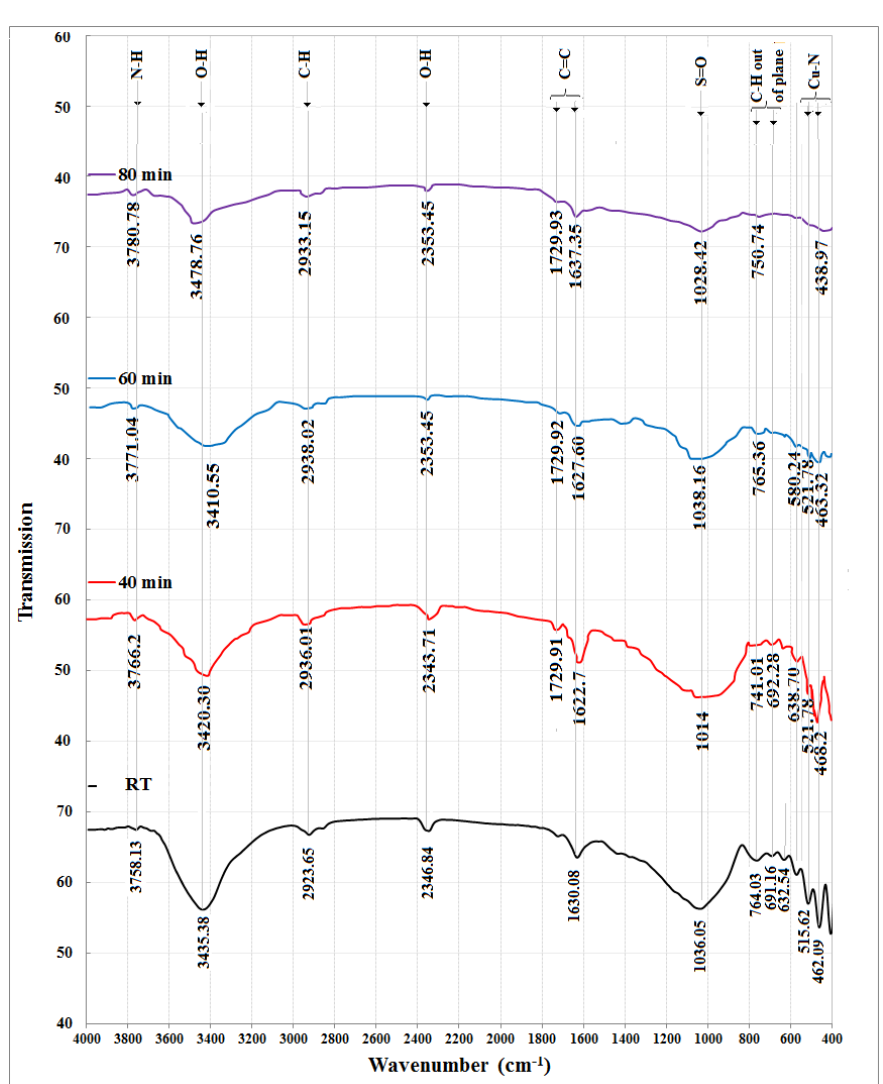
Fig. 4: FTIR patterns for CuPcTs:BEDOT PSS thin films chemically treated with talwen at different